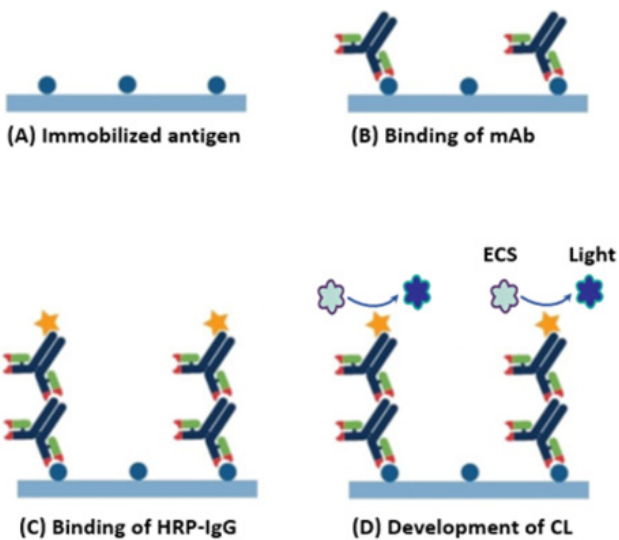
Figure 1. Illustrative diagram of the CLEIA for mAbs. ( A ) the antigen (VEGF) is immobilized onto the inner surface of the microwells of the assay plate and blocked with BSA. ( B ) binding of mAb (BEV) to the immobilized VEGF. ( C ) binding of HRP-IgG to the antigen-mAb complex. ( D ) development of CL by the HRP-luminol-H 2 O 2 reaction using the IMP as a CL enhancer. Abbreviations were: CLEIA, chemiluminescence enzyme immunoassay; mAb, monoclonal antibody; VEGF, epidermal growth factor receptor; BSA, bovine serum albumin; BEV, bevacizumab; IMP, 4-(imidazol-1-yl)phenol.